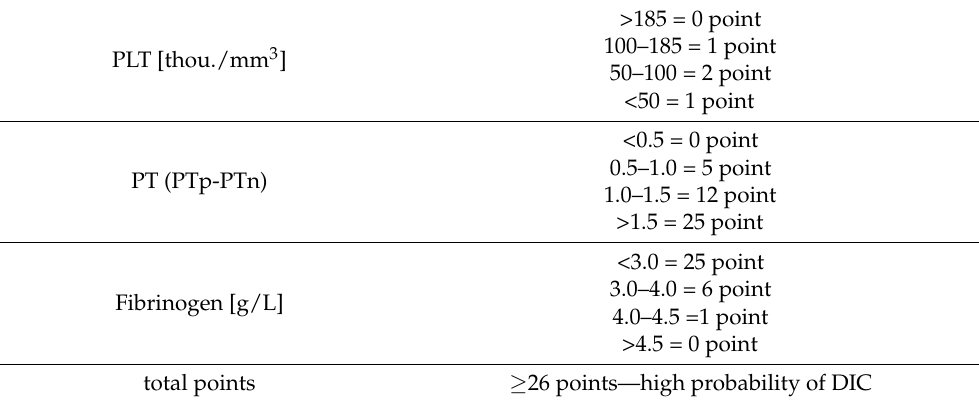
Table 5. DIC risk assessment scale in pregnancy according to Erez et al. (2014) [17].